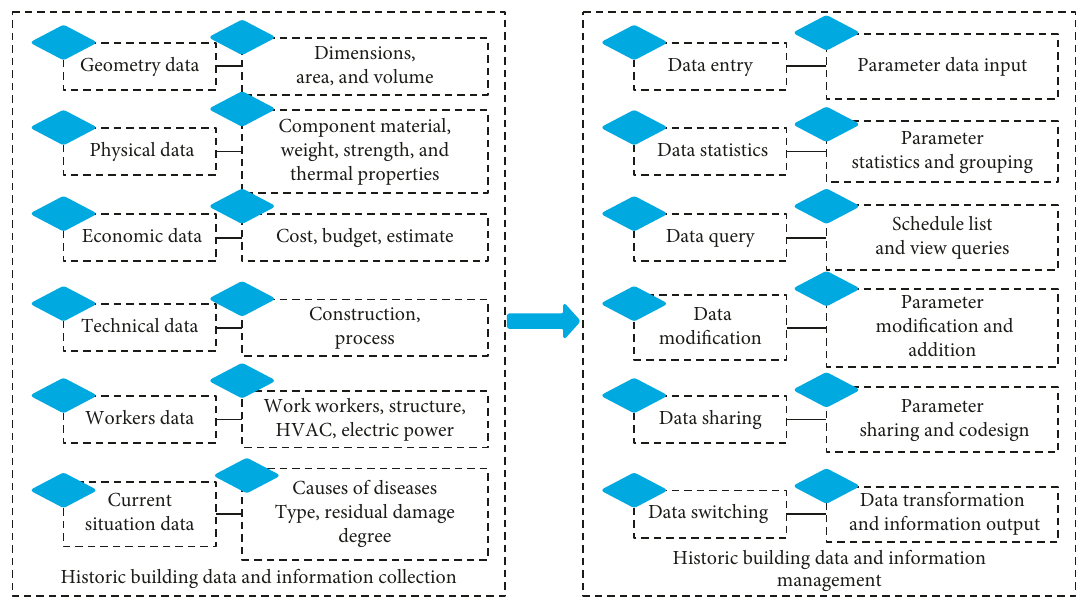
Figure 6: Comprehensive data information of historical buildings.